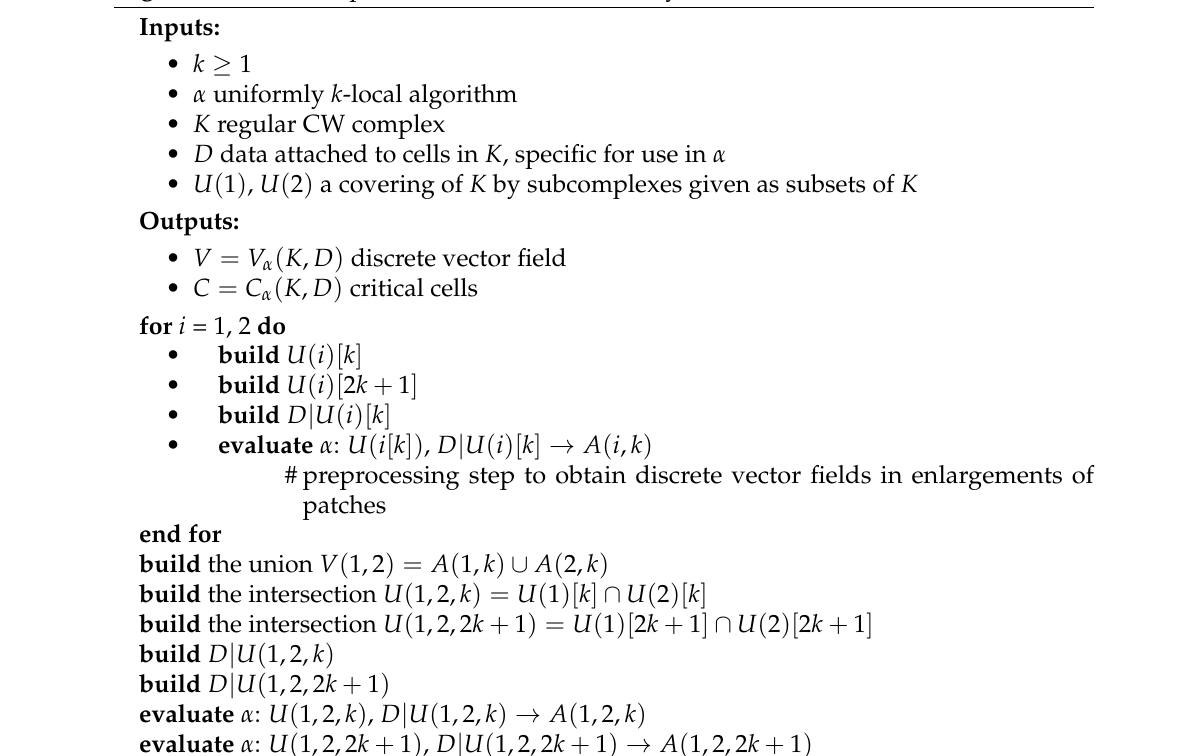
Algorithm 1 Two-set parallelization from Corollary